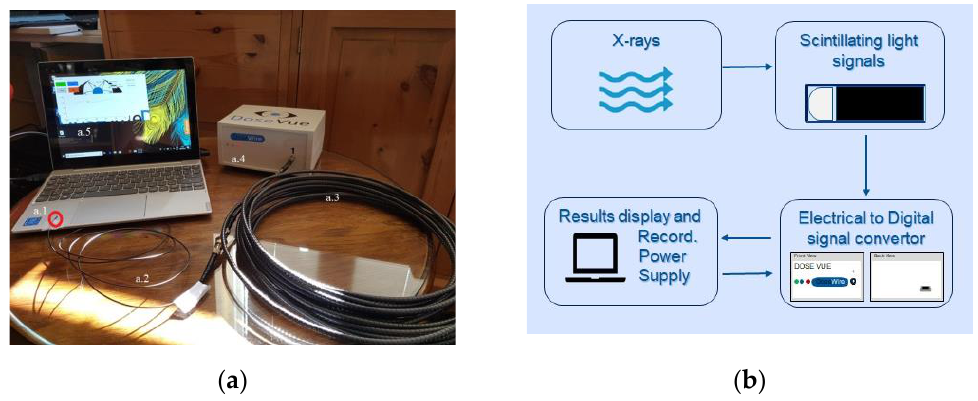
Figure 1. ( a ) DoseVue system: (a.1) DoseWire detector, (a.2) optical fibre, (a.3) extension cable, (a.4) signal convertor interface, (a.5) DoseVue software. ( b ) Signal acquisition workflow.